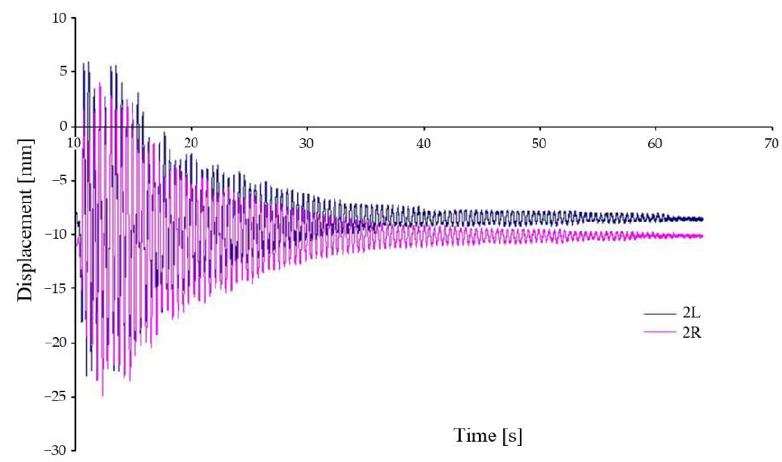
Figure 11. Relative displacement between car body and chassis frame—variant A–I.